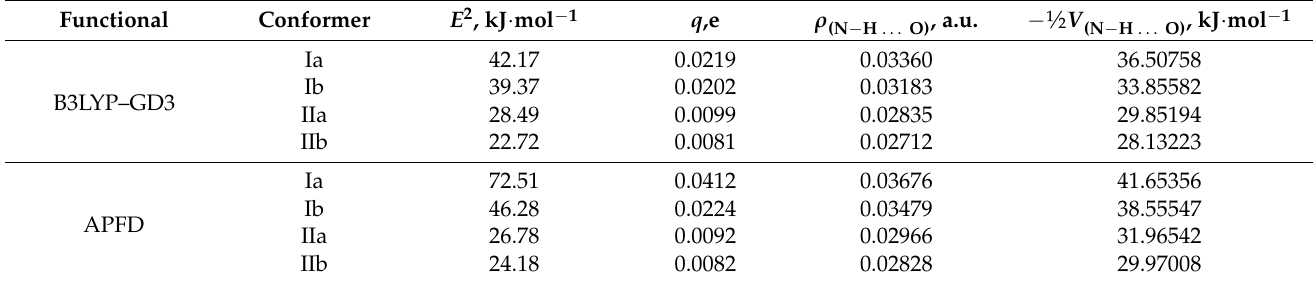
Figure 4. Schematic representation of the MA molecule conformers: Ia, Ib, IIa, IIb. Table 3. Orbital stabilization energy E 2 of the electron pair acceptor (antibonding orbital BD*(N–H)) , charge transfer q from the bonding orbital (LP(O)) to the antibonding acceptor orbital (BD*(N–H)) (calculated within NBO), electron density ρ at the (3, −1) bond path critical point, and bond potential energy ½ V (calculated within QTAIM) for MA conformers.